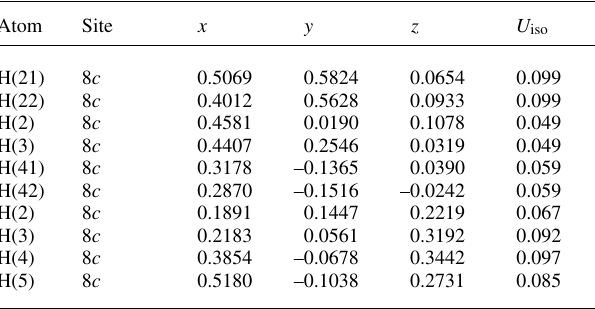
Table 2. Atomic coordinates and displacement parameters (in Å 2 )